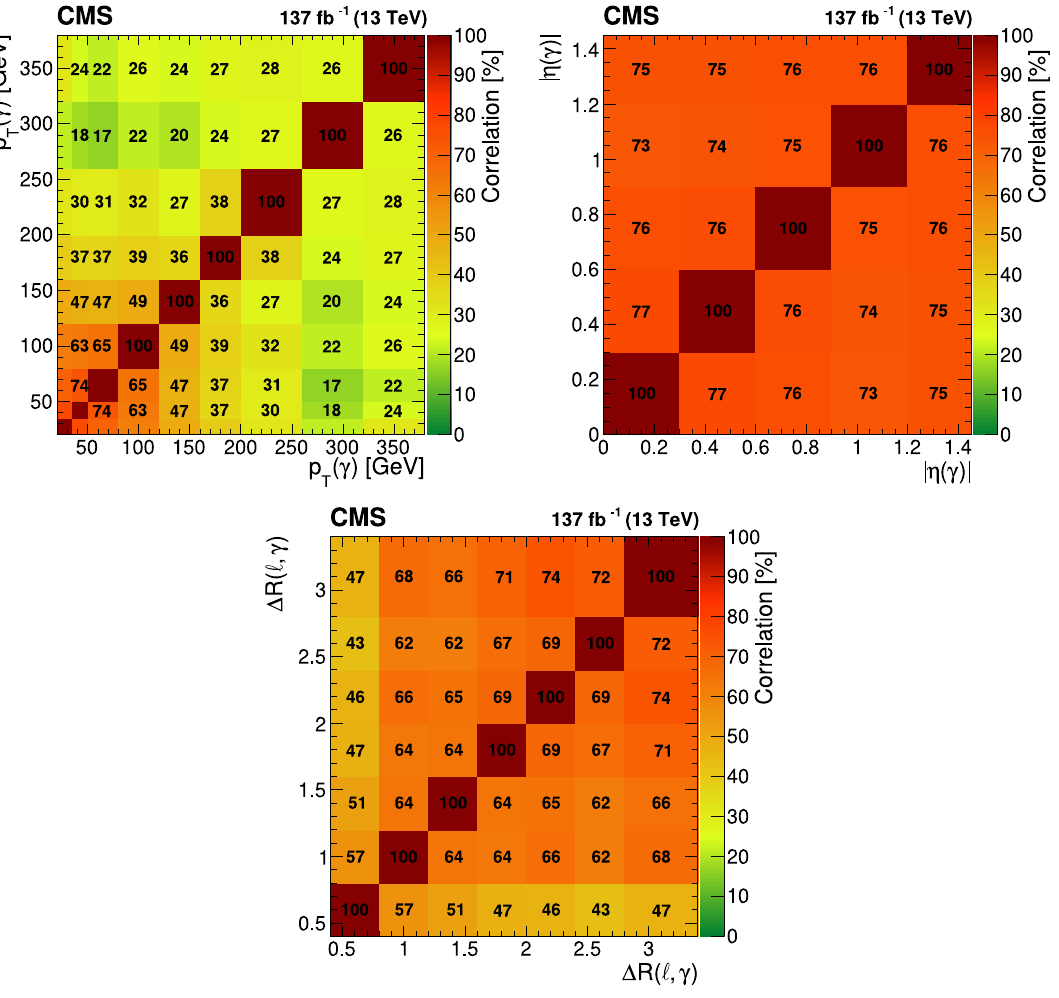
Figure 10 . The correlation matrices of systematic uncertainties for the unfolded differential mea- surement for p ( γ ) (upper left), | η ( γ ) | (upper right), and ∆ R ( ‘, γ ) T